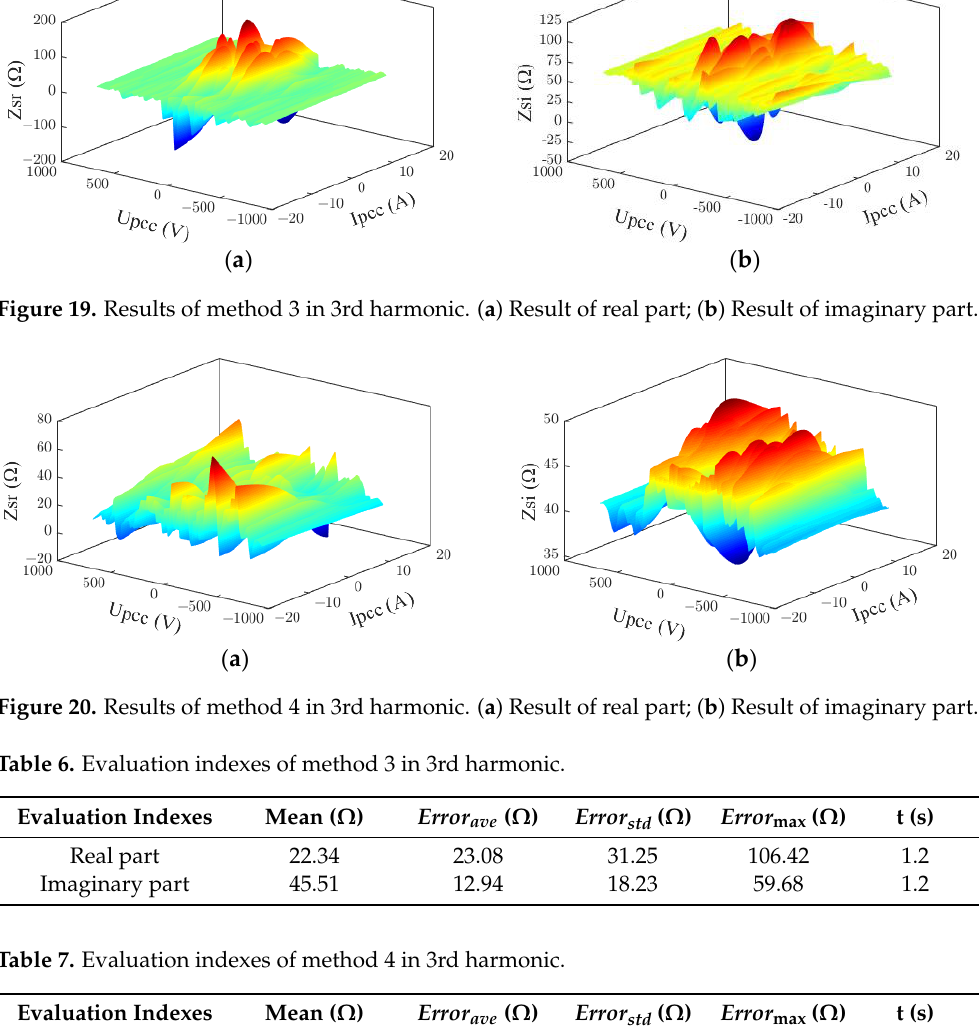
Figure 19. Results of method 3 in 3rd harmonic. ( a ) Result of real part; ( b ) Result of imaginary part. Table 6. Evaluation indexes of method 3 in 3rd harmonic.